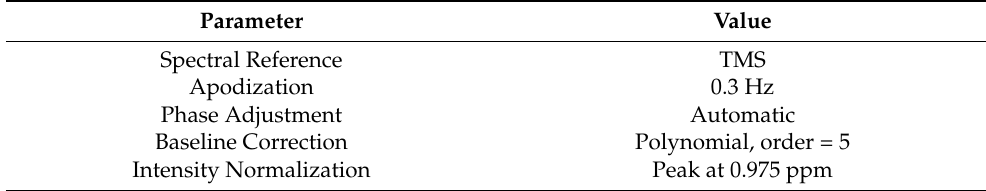
Table 2. Spectral processing